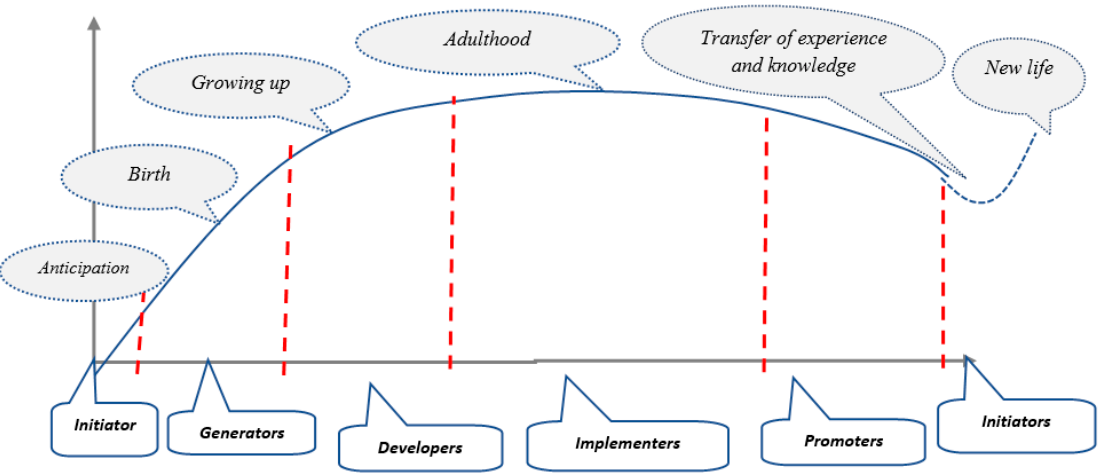
Figure 1. Project’s life cycle in the ecosystem [29].